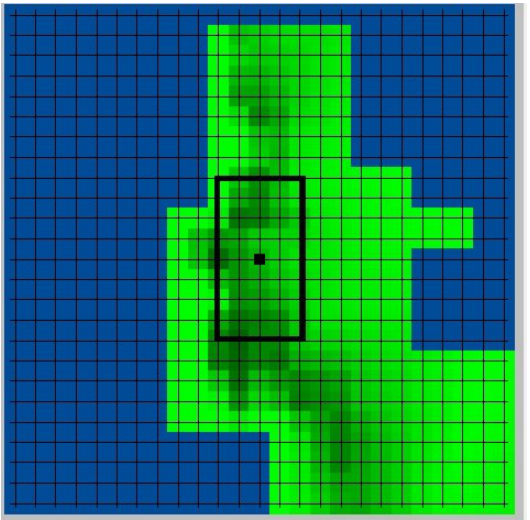
Figure 5. TAPM forecast grids, with the central point the centre of the wind farm. The black box shows the area encompassing the surrounding grid points.